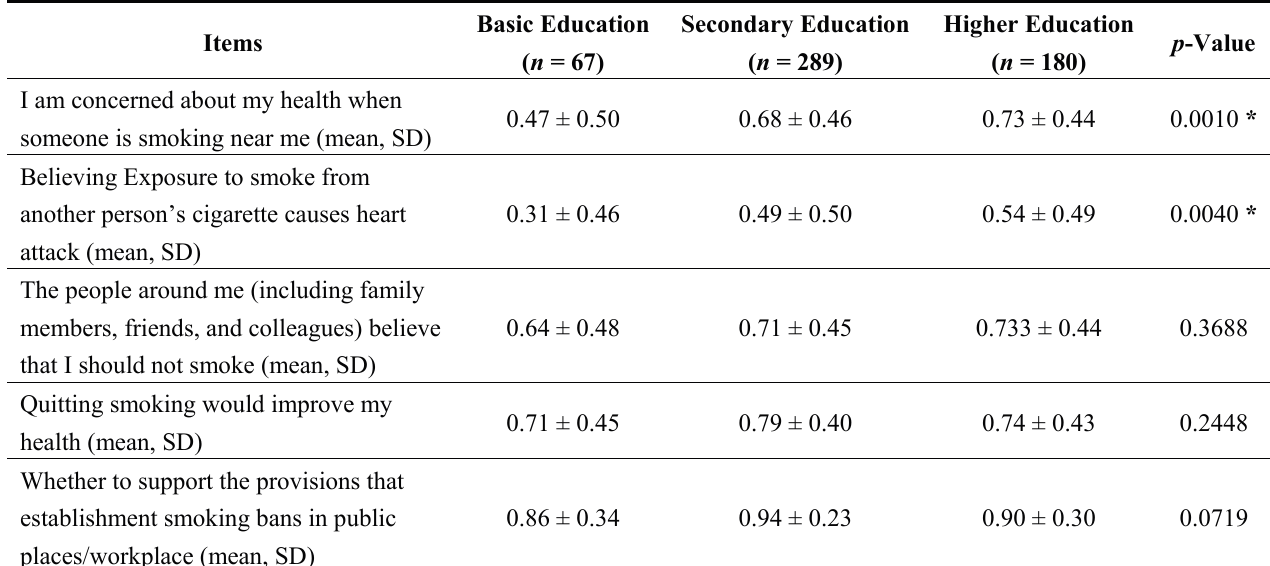
Table 3. Smokers’ smoking-related attitude, Chongqing, China,